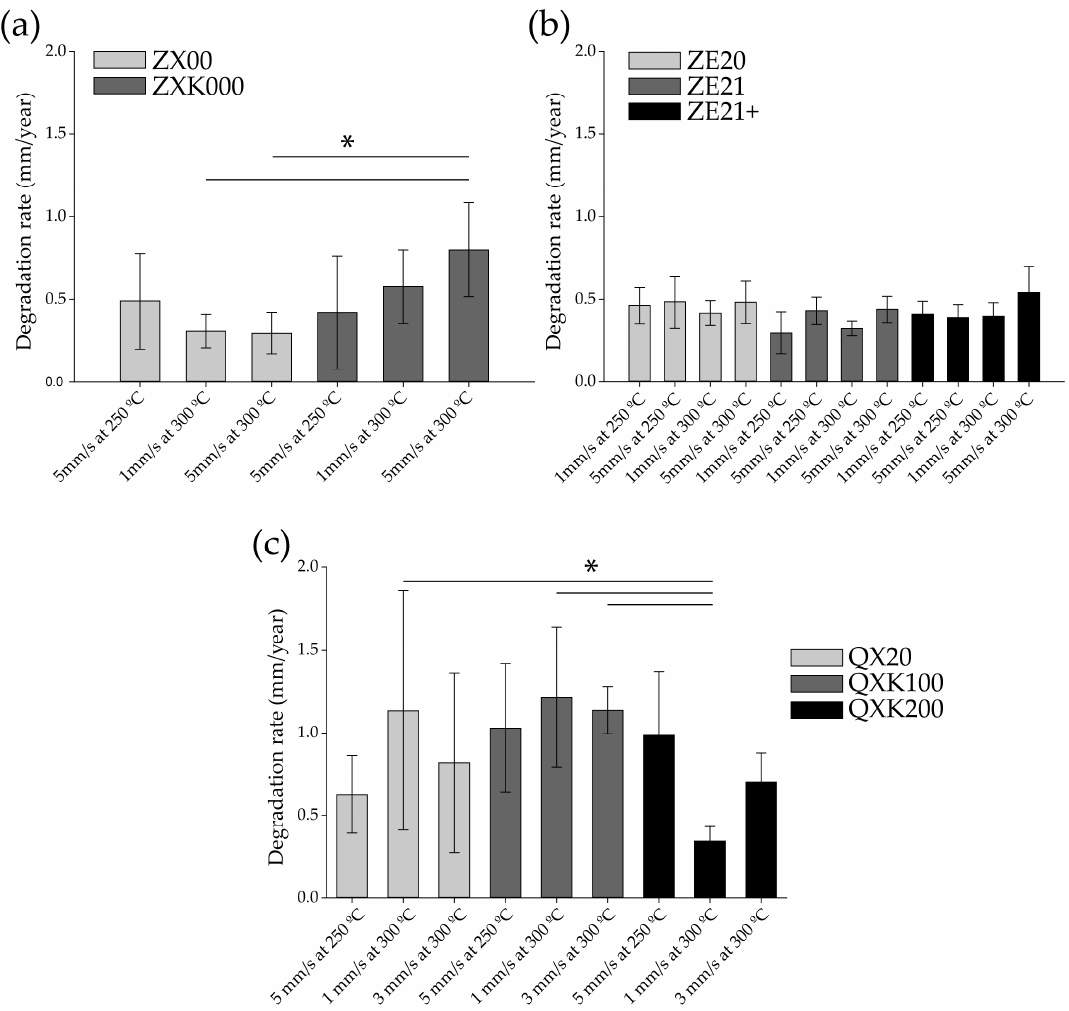
Figure 7. Degradation rates (mm/year) of the different alloy series: ( a ) ZX, ( b ) ZE, and ( c ) QX. Bars represent the arithmetical mean ± standard deviation (SD). Stars indicate statistically significant difference between treatments (* p ≤ 0.05).